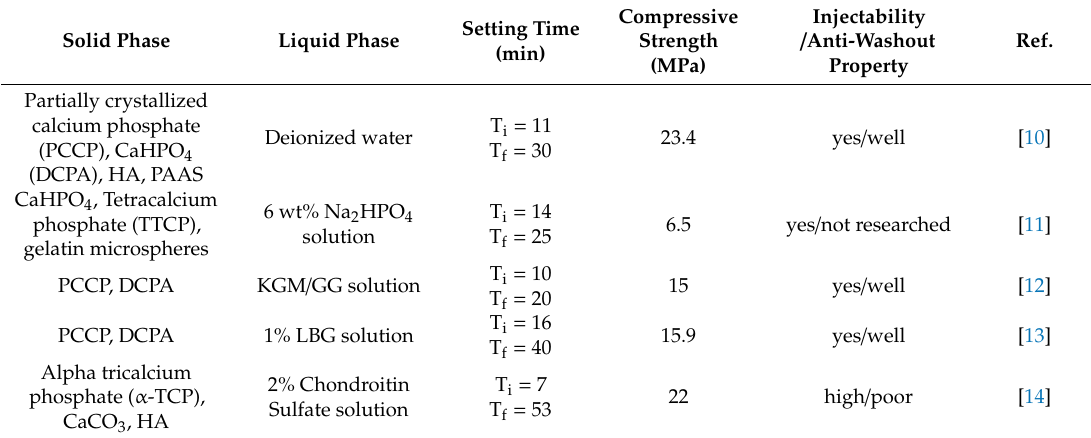
Table 1. Composition and physicochemical properties of other studies concerning